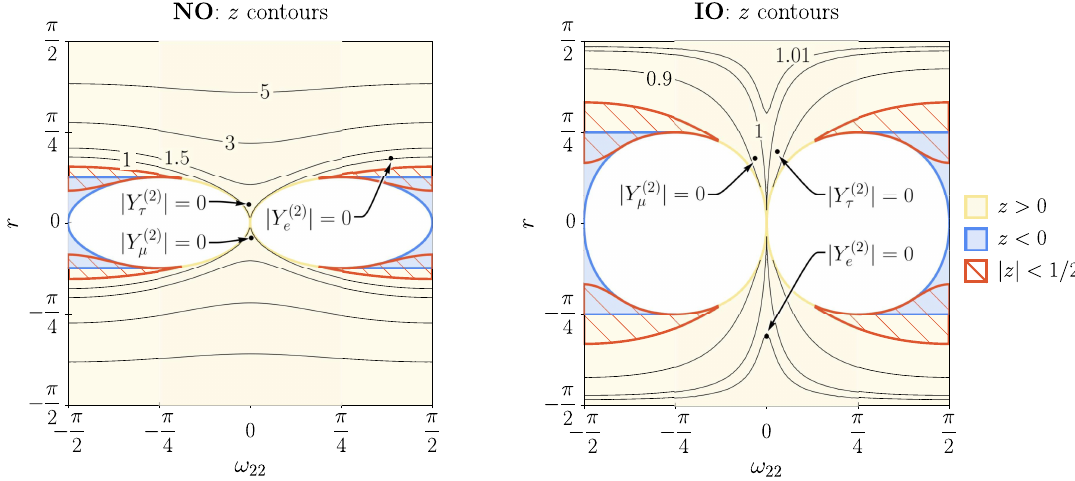
Figure 3. Parameter regions of the ω 22 − r plane, representing two out of the four physical input parameters of the model r , ω 22 , m 4 and Λ . The definition of z , eq. (2.26), is essential for the | | restrictions of ω 22 and r , as it has to be real as discussed in appendix B. The white areas are excluded by not fulfilling eq. ( B.7). The contours of the values of z are in the range allowed by eq. (2.27), except for the red striped region, where z < 1 , which we exclude as being fine- 2 | | tuned. These red striped areas will also be colored white in later plots, as we will not consider this parameter region for the discussed exclusion criteria. The points where the second Yukawa coupling to electrons, muons, or taus vanish exactly are also shown for both